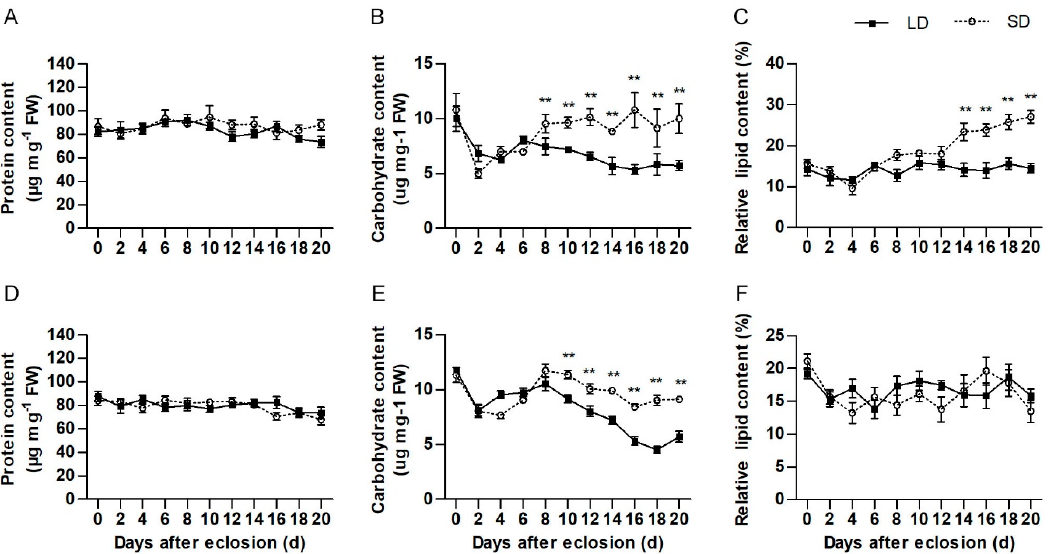
Figure 4. Di ff erences in nutrient storage between pre-diapause and pre-reproductive adult H. axyridis . Protein accumulation in females ( A ) and males ( D ), Carbohydrate accumulation in females ( B ) and males ( E ), and lipid accumulation of females ( C ) and males ( F ). Values of protein and carbohydrate content are means ± standard error estimated from 5 independent biological replicates. Values of lipid content are means ± standard error estimated from 10 independent biological replicates. LD = pre-reproductive beetles reared under a long-day condition and SD = pre-diapause beetles reared under a short-day condition. Asterisks indicate significant di ff erences determined by an independent samples t -test (* p < 0.05, ** p < 0.01).